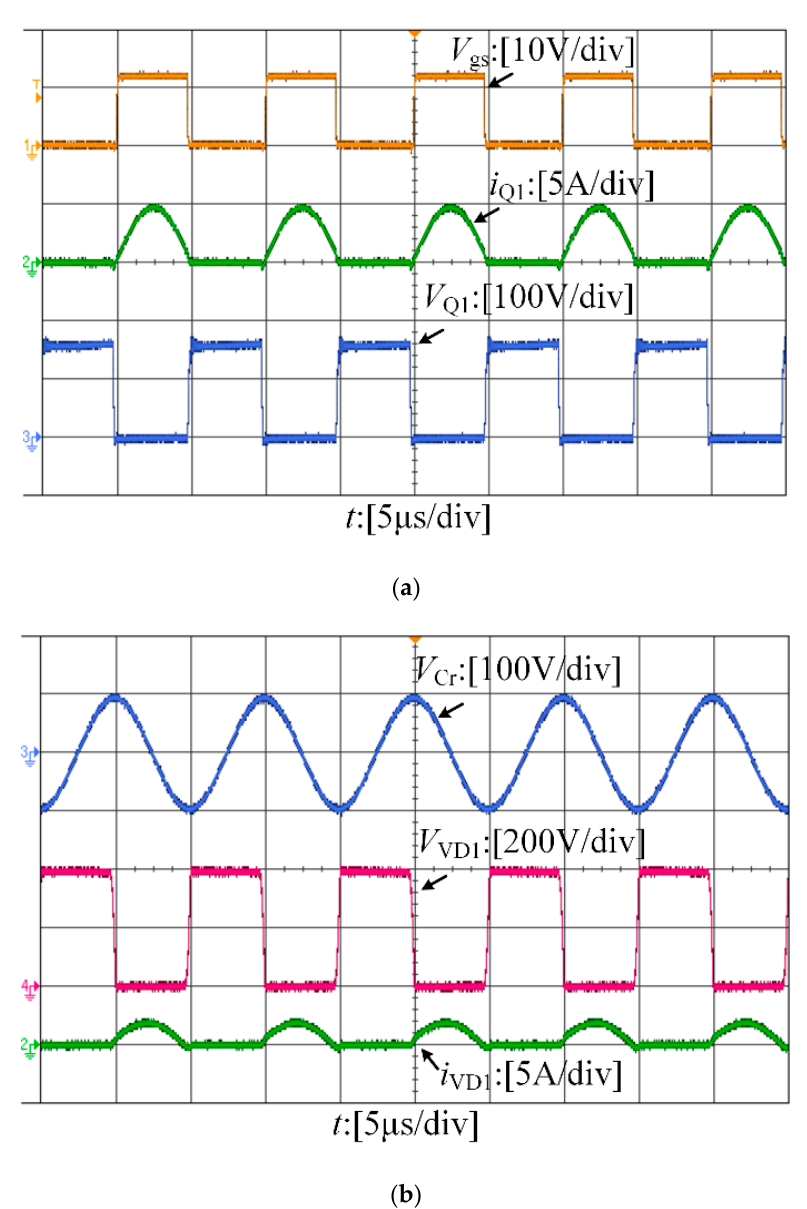
Figure 13. Experimental waveforms at rated point. ( a ) Waveforms of Q 1 . ( b ) Waveforms of VD 1 and C r .